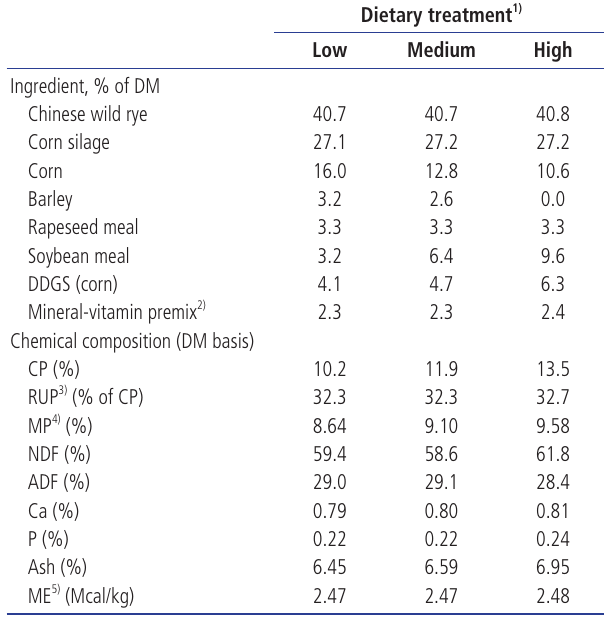
Table 1. Composition of diets with low, medium, and high protein